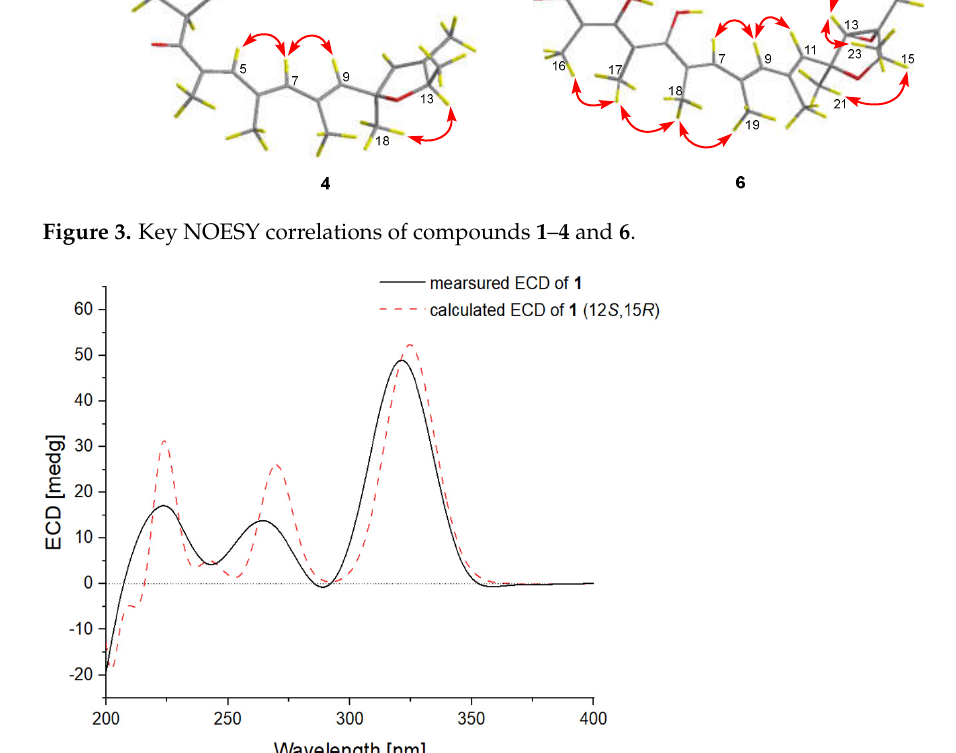
Figure 4. Experimental ECD spectrum of 1 (black line) compared with that calculated for (12 S ,15 R )– isomer of 1 at BH&HLYP/TZVP level (red dashed line).